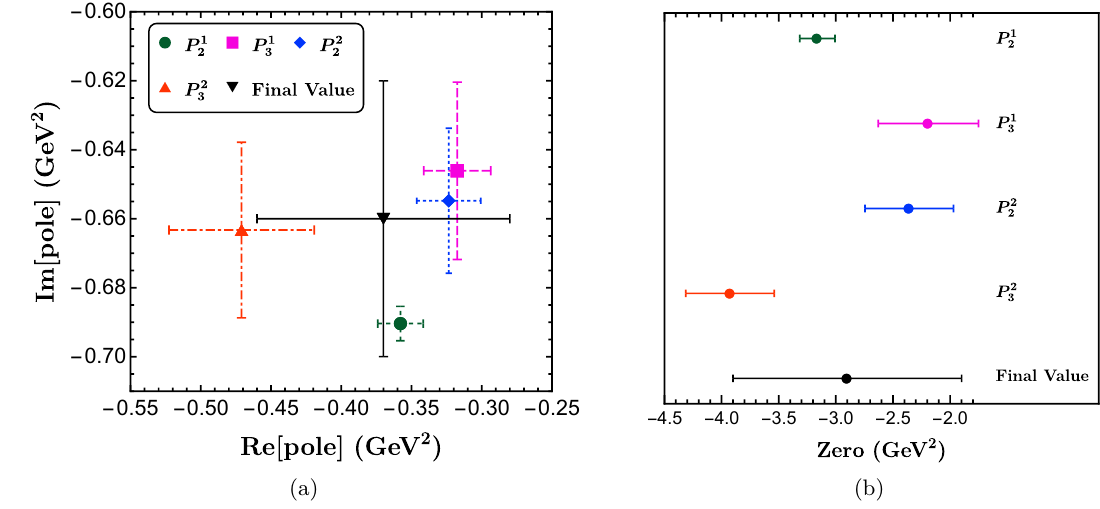
Figure 5 . Padé approximants used to determine the final results. In (a) we have the poles of each PA and in (b) the zeros. In both cases, we show our final prediction in black. Note that the Padés P 1 and P 2 belong to the same sequence P N . Also note that in this plot we added in quadrature 2 3 N +1 the two types of errors.